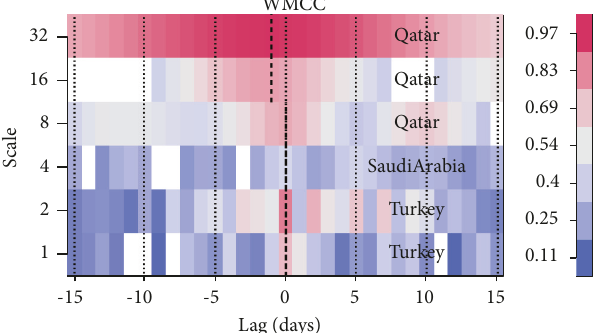
Figure 4: Wavelet multiple cross correlation between systematic risk of Africa and Middle East (18/08/2010–03/11/2020).